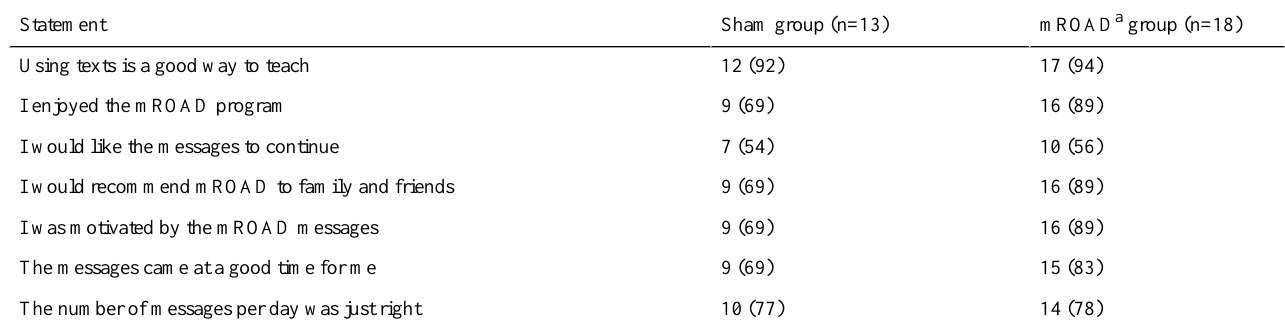
Table 2. Acceptability as indicated by participants’agreement with the following statements at 30 day follow-up, n